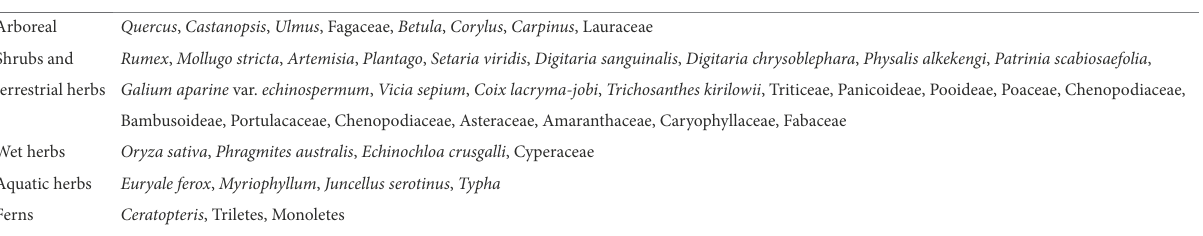
TABLE 3 Main local vegetation landscape of the Shunshanji cultural site group. Plant type